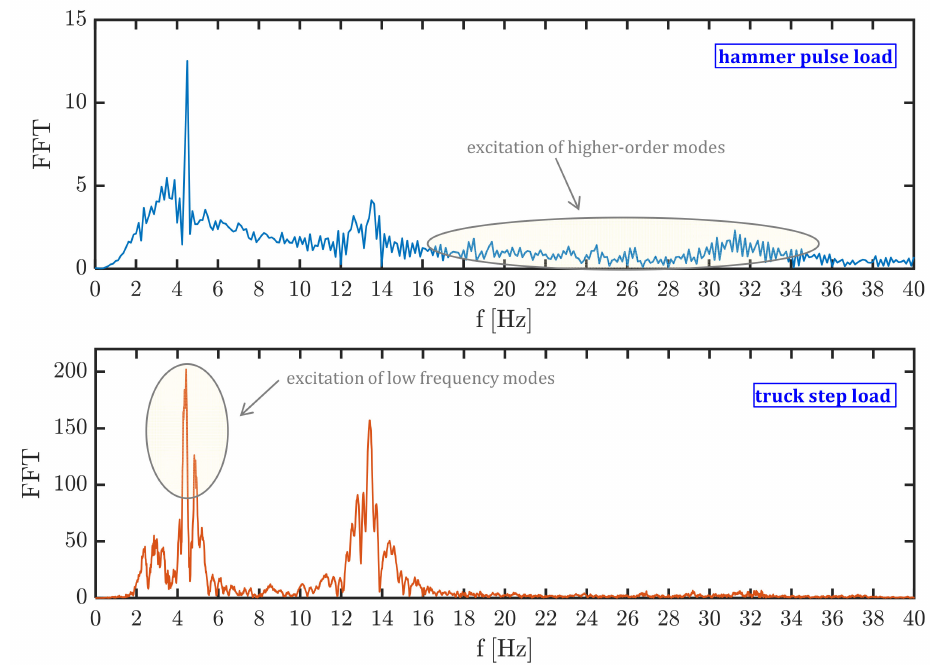
Figure 7. FFT of the S1 signal under hammer pulse load ( top ) and truck step load ( bottom